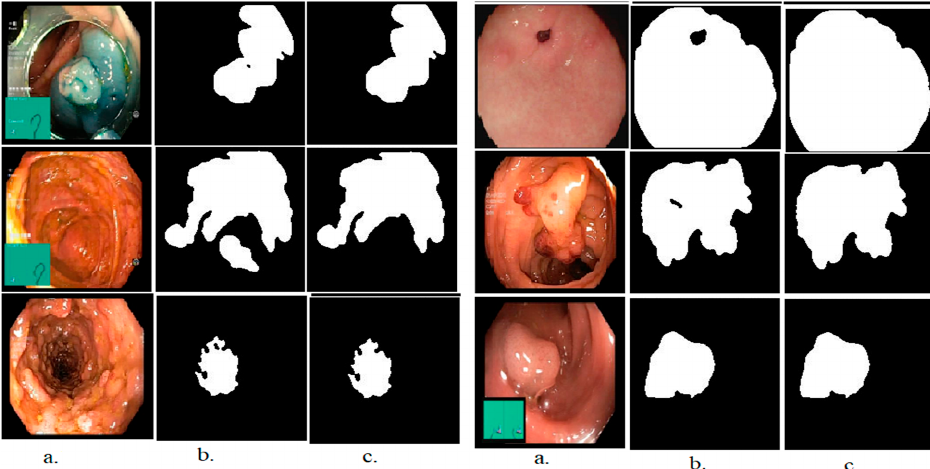
Figure 3. Samples of the dataset ( a ) original image ( b ) After the segmentation ( c ) After the morpho- logical .